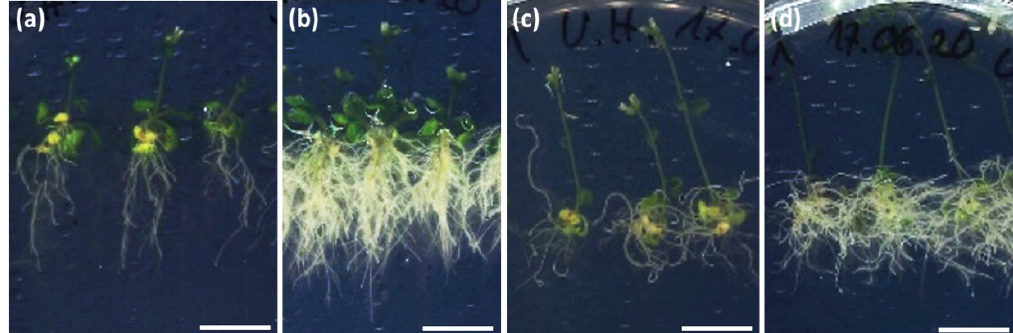
Figure 7. Root phenotype of ecotype Landsberg erecta (Ler-0) and auxin resistant 1 ( aux 1)-mutants of A. thaliana when incubated with C. asteris for 21 days. A. thaliana and C. asteris were co-cultivated on ½ MS/MEAlow under long day con- ditions. ( a ) Ecotype Ler-0 control, ( b ) ecotype Ler-0 co-cultivated with C. asteris . ( c ) aux 1-mutant of A. thaliana , ( d ) aux 1- mutant of A. thaliana co-cultivated with C. asteris . The bar indicates 1 cm.